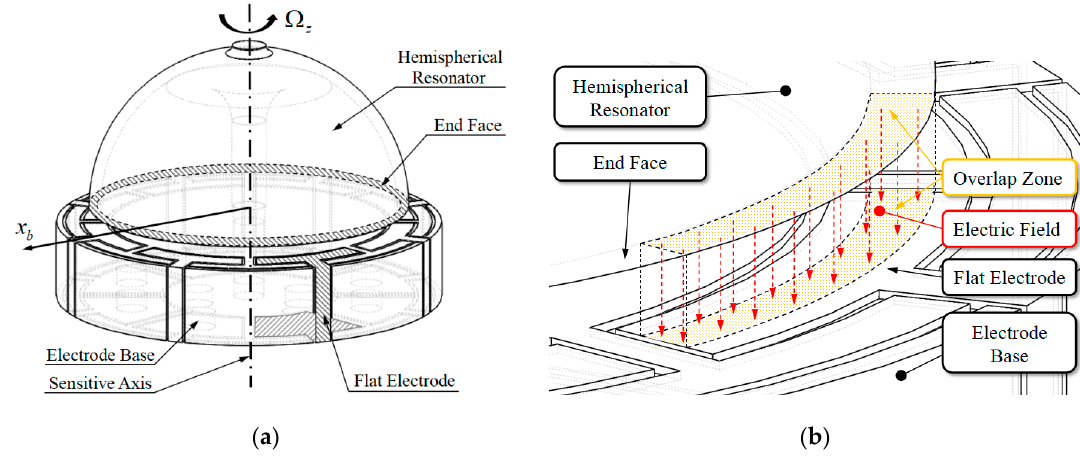
Figure 6. Flat-electrode Hemispherical Resonator Gyro (HRG): ( a ) Dominant structure of flat-electrode HRG; and, ( b ) Excitation and detection capacitor.